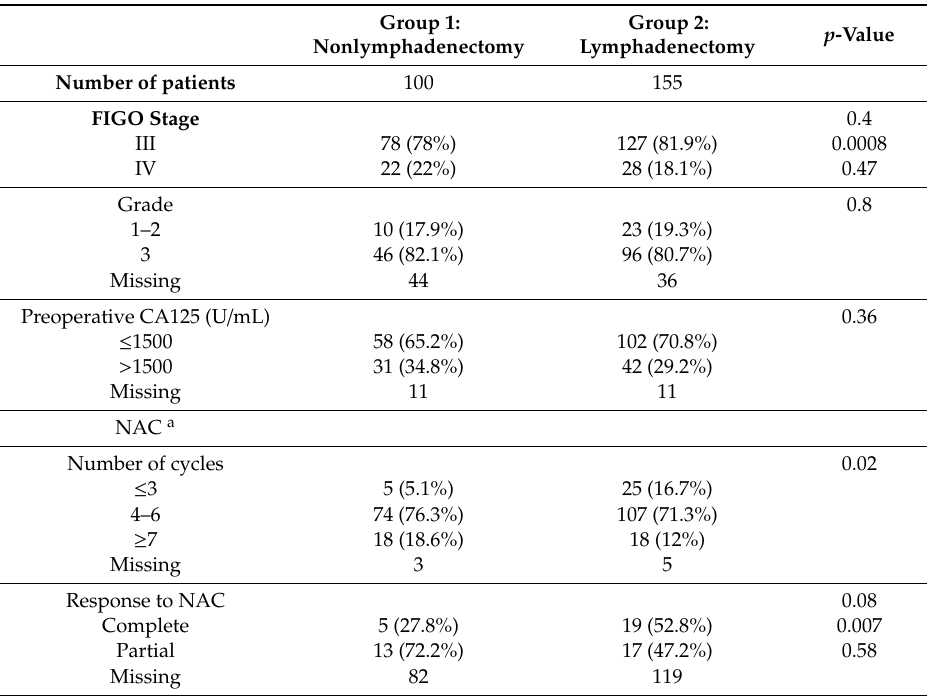
Table 2. Tumoral